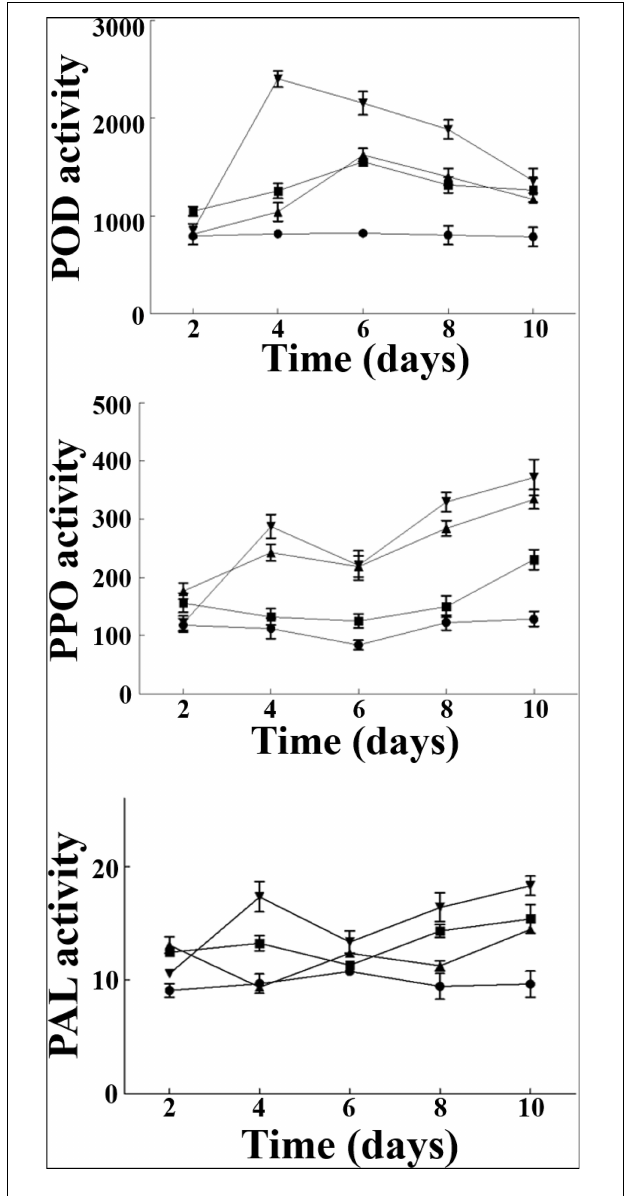
FIGURE 4 | Effect of B. siamensis YC-9 on POD, PPO, and PAL activities (U/g · Fw · h) of cucumber root. A( ): CK; B( (cid:4) ): only YC-9 suspension were inoculated; C( (cid:78) ): only FOC suspension were inoculated; D( (cid:72) ): challenge (cid:32) inoculation with FOC suspension after 48 h of YC-9 suspension inoculation. Each data point represents the mean ± standard deviation of three replicates in each treatment group. Error bars represent the standard deviation from three